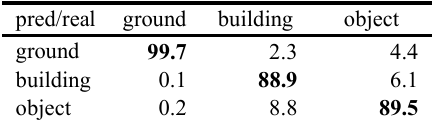
Table 4: Confusion matrix (% recall ) for 3 classes, 500 hidden layers and unweighted.